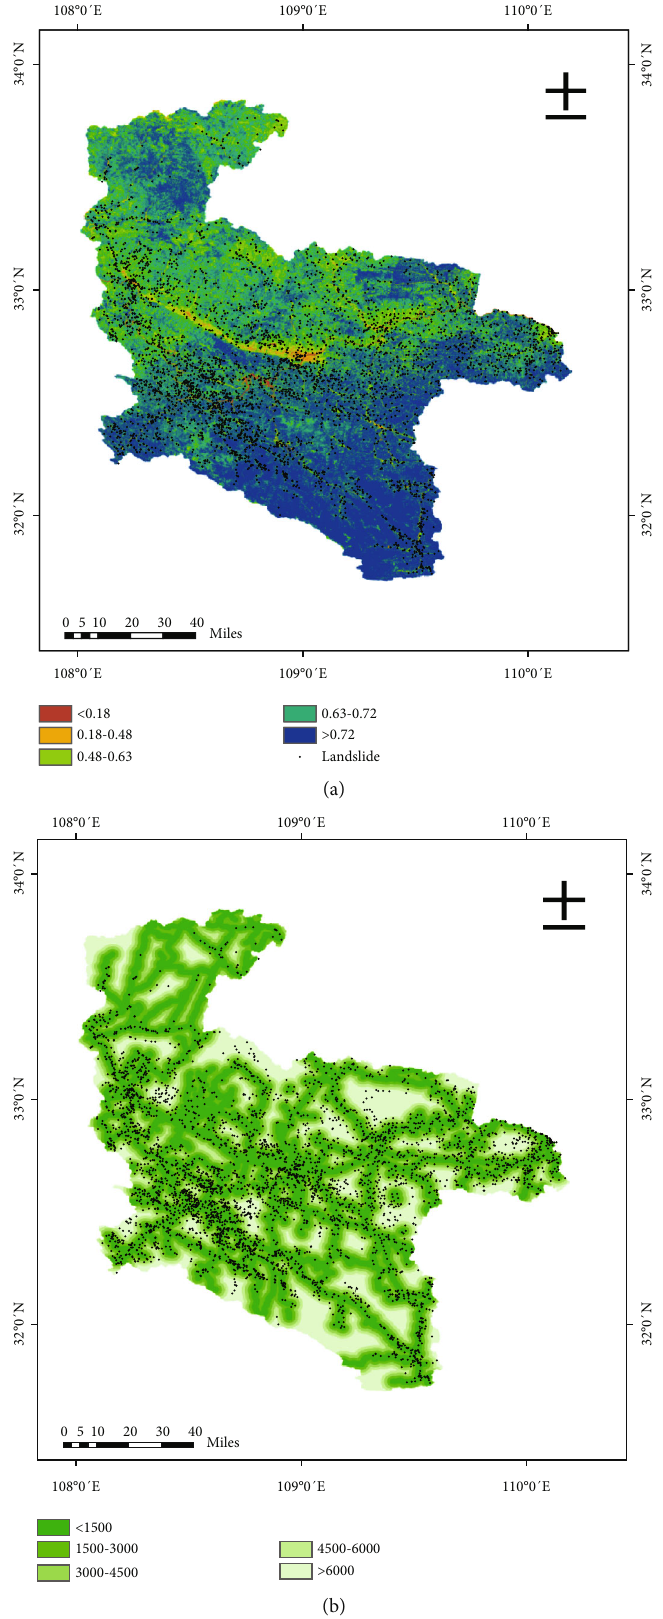
Figure 4: Human engineering activities factors mapping of the study area: (a) normalized di ff erence vegetation index; (b) distance to